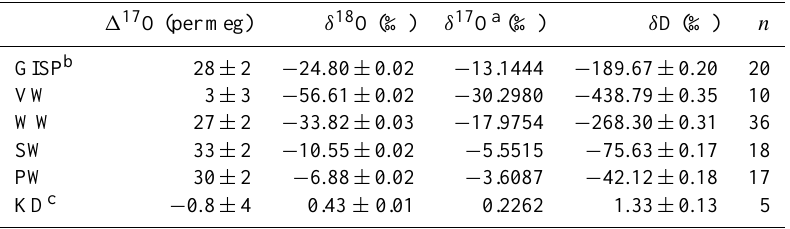
Table 1. VSMOW-SLAP-normalized isotopic ratios of reference waters analyzed at the University of Washington “ 1 *IsoLab”. 1 17 O values are from long-term average IRMS measurements, updated from Schoenemann et al. (2013) to reflect the inclusion of additional data. δ 18 O and δ D values are from long-term average laser spectroscopy measurements. δ 17 O values are calculated from 1 17 O and δ 18 O (Eq. 5). √ n ). n is the sample size. Precision ( ± ) is the standard error ( σ/ 1 17 O (per meg) δ 18 O (‰) δ 17 O a (‰) δ D (‰) n GISP b 28 ± 2 − 24 . 80 ± 0 . 02 − 13.1444 − 189 . 67 ± 0 . 20 20 VW 3 ± 3 − 56 . 61 ± 0 . 02 − 30.2980 − 438 . 79 ± 0 . 35 WW 27 ± 2 − 33 . 82 ± 0 . 03 − 17.9754 SW 33 ± 2 − 10 . 55 ± 0 . 02 PW KD c − 0 . 8 ± 4 0.43 ± 0.01 0.2262 1 . 33 ± 0 . 13